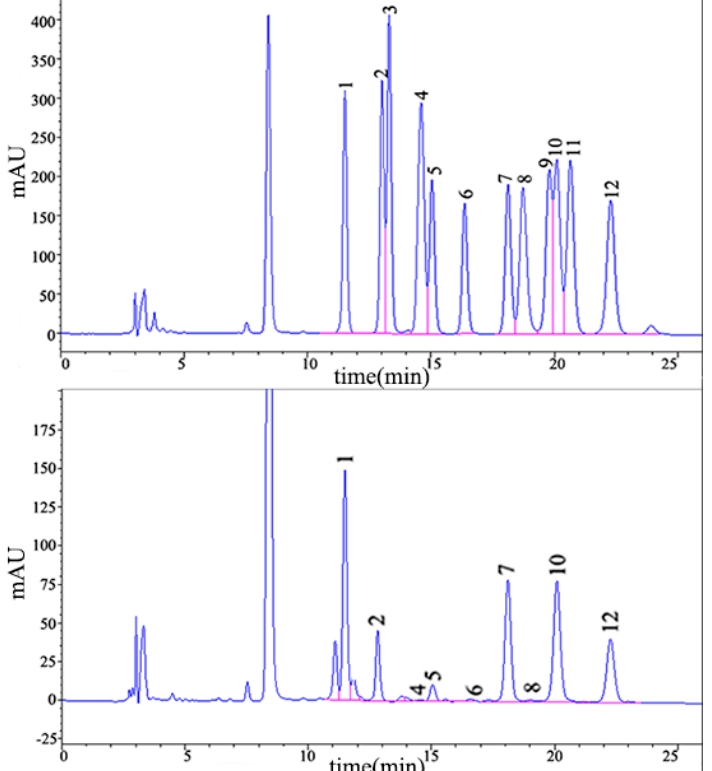
Figure 3. The monosaccharide composition analysis of the pumpkin polysaccharides by HPLC. The upper panel shows the monosaccharide control, and the lower panel shows the pumpkin polysaccharides. 1. mannose, 2. ribose, 3. rhamnose, 4. glucosamine, 5. glucuronic acid, 6. galacturonic acid, 7. glucose, 8. galactosamine, 9. galactose, 10. xylose, 11. arabia sugar, and 12. fucose.